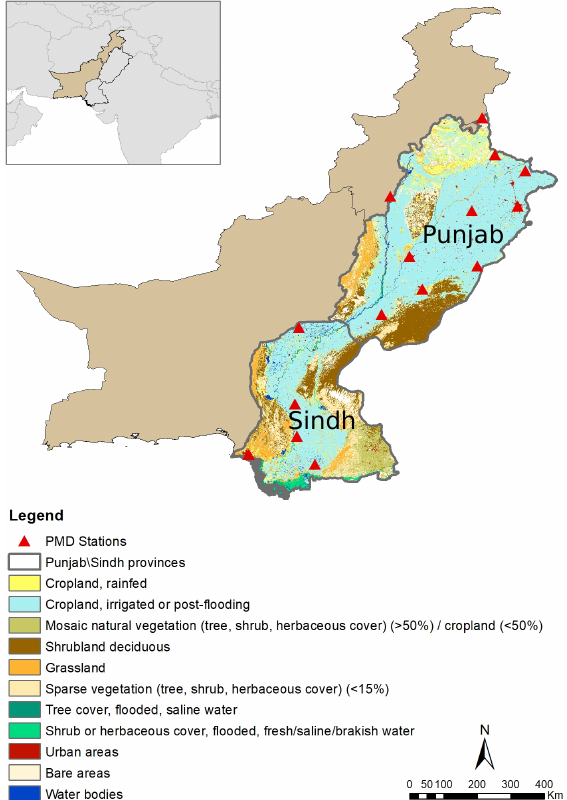
Figure 1. Study area and location of the 15 weather stations used in this work (red triangles), together with a land-use map for the Punjab and Sindh provinces. Note that the Jammu and Kashmir regions, whose current status has not yet been agreed upon the different parties involved, are not shown in the map. Sources: PMD and